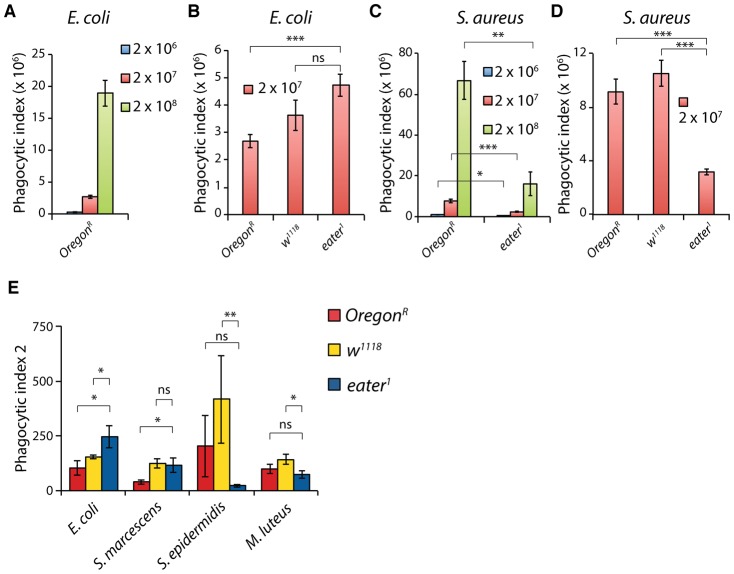
eater1 null hemocytes have defects in phagocytosis of Gram-positive but not Gram-negative bacteria.(A,B) Phagocytosis of AF488-labelled heat-killed Escherichia coli by ex vivo hemocytes from OregonR, w1118 and eater1 mutant larvae. Larvae were bled, hemocytes collected, mixed with heat-killed bacteria and incubated at room temperature for 20 min. (A) Phagocytosis index of OregonR hemocytes incubated with 2×106, 2×107 or 2×108
E. coli (n = 6, n = 12 and n = 2, respectively). (B) Phagocytosis by eater1 mutant hemocytes when incubated with 2×107
E. coli is like wild type (n = 6 or more, each). In this and all other figures, unless otherwise indicated, statistical tests were performed using Students t test, *p<0.05, **p<0.01 and ***p<0.001 and ‘ns’ indicates not significant. Error bars represent SEM. (C,D) Phagocytosis of AF488-labelled heat-killed Staphylococcus aureus by ex vivo hemocytes from OregonR, w1118 and eater1 mutant larvae. (C) eater1 null hemocytes are inefficient at phagocytosing S. aureus compared to wild type hemocytes, at all titres tested, 2×106, 2×107 and 2×108
S. aureus (n = 5 or more, each). Performed using 20 larval bleeds per assay, as in A,B. (D) The phagocytic index of hemocytes incubated with 2×107
S. aureus (n = 6 or more, each). In this latter plot, equal numbers of hemocytes were used across genotypes by compensating for variation in the number of hemocytes per larva (see Fig. 3A; Materials and methods) by varying the number of larvae bled. (E) Phagocytosis of AF488-labelled heat-killed Gram-negative Escherichia coli and Serratia marcescens and Gram-positive Staphylococcus epidermidis and Micrococcus Luteus by OregonR, w1118 and eater1 ex vivo larval hemocytes. A titre of 2×106 bacteria was used. n number of experimental repeats; E.c.; Oregon (6), w1118 (3) and eater1 (5); S.m.; Oregon (4), w1118 (3) and eater1 (5); S.e.; Oregon (4), w1118 (4) and eater1 (5); M.l. Oregon (6), w1118 (5) and eater1 (5). Mean Phagocytic indices are plotted using the same formula as in A,B but different arbitrary fluorescence units. For each condition we performed a Shapiro-Wilk test of normality. For non-parametric datasets, we performed pair-wise Wilcoxon tests.